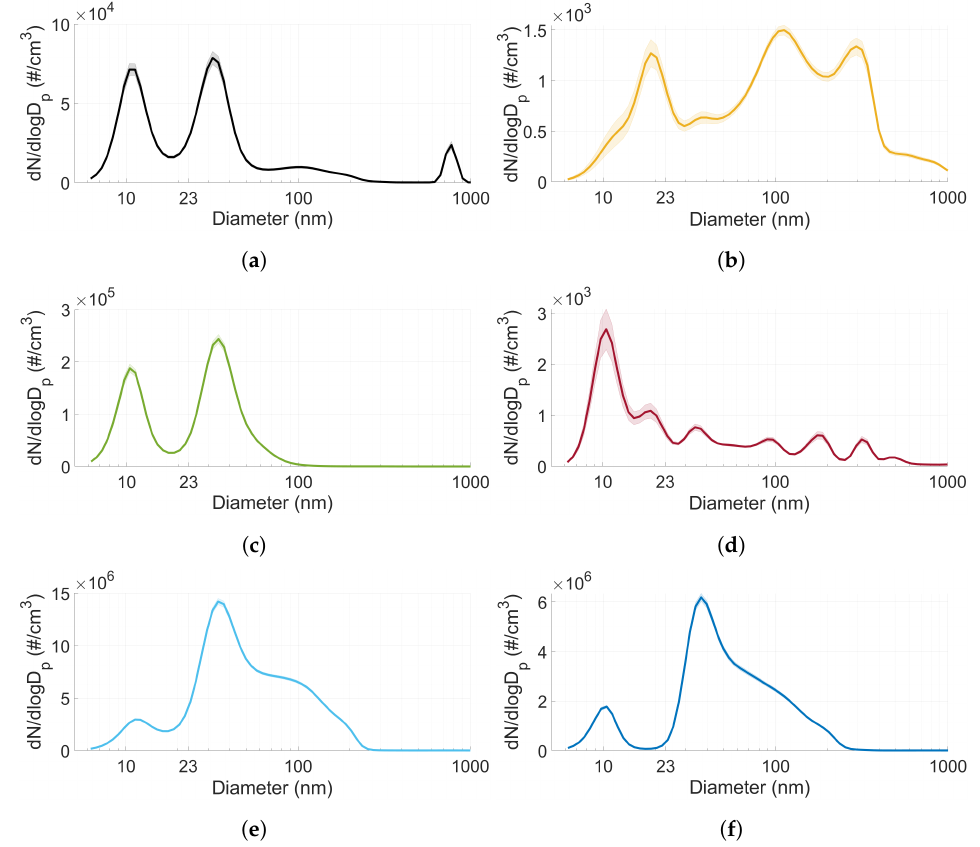
Figure 7. The total particle size distribution for particle emissions for ( a ) gasoline, ( b ) MTBE, ( c ) ethanol, ( d ) methanol, ( e ) n-butanol and ( f ) iso-butanol at 1500 RPM and 13 bar IMEP. The shad- owed areas show the normalised random error ( ± (cid:101) ).